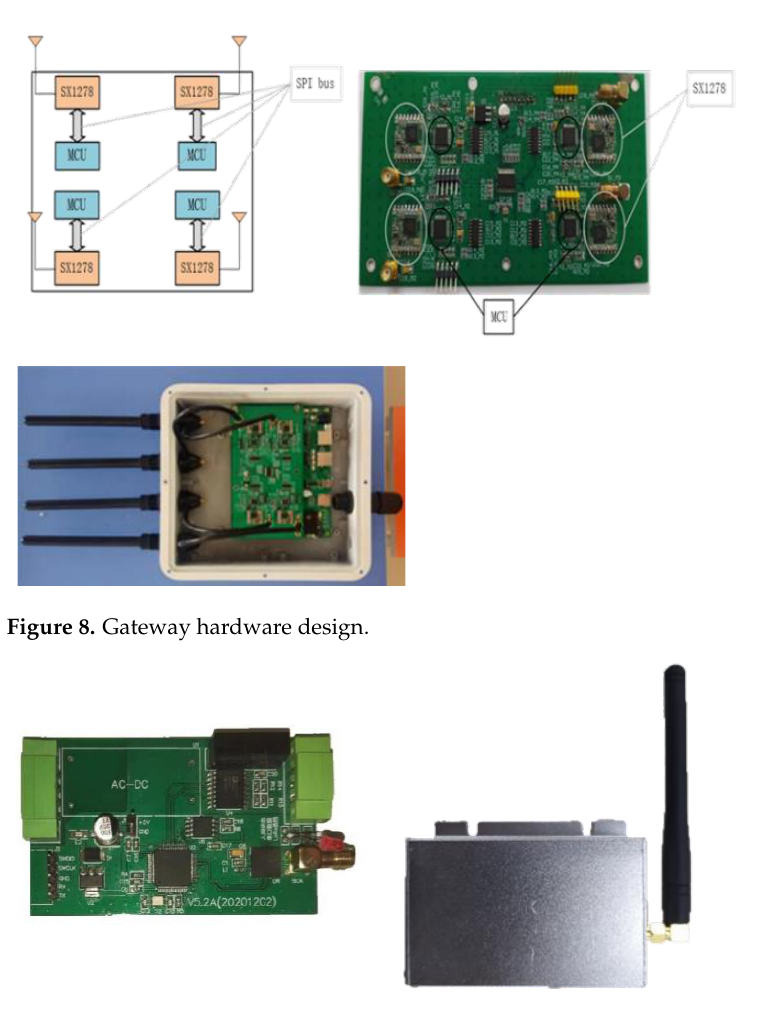
Figure 9. ED hardware design.